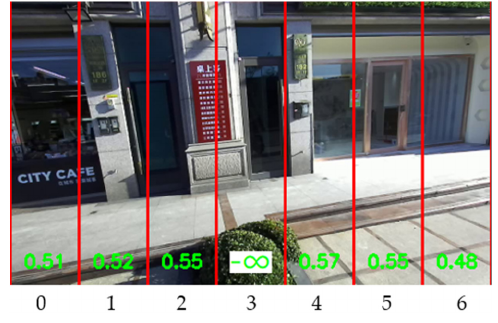
Figure 6. Seven divisions with Conf d .